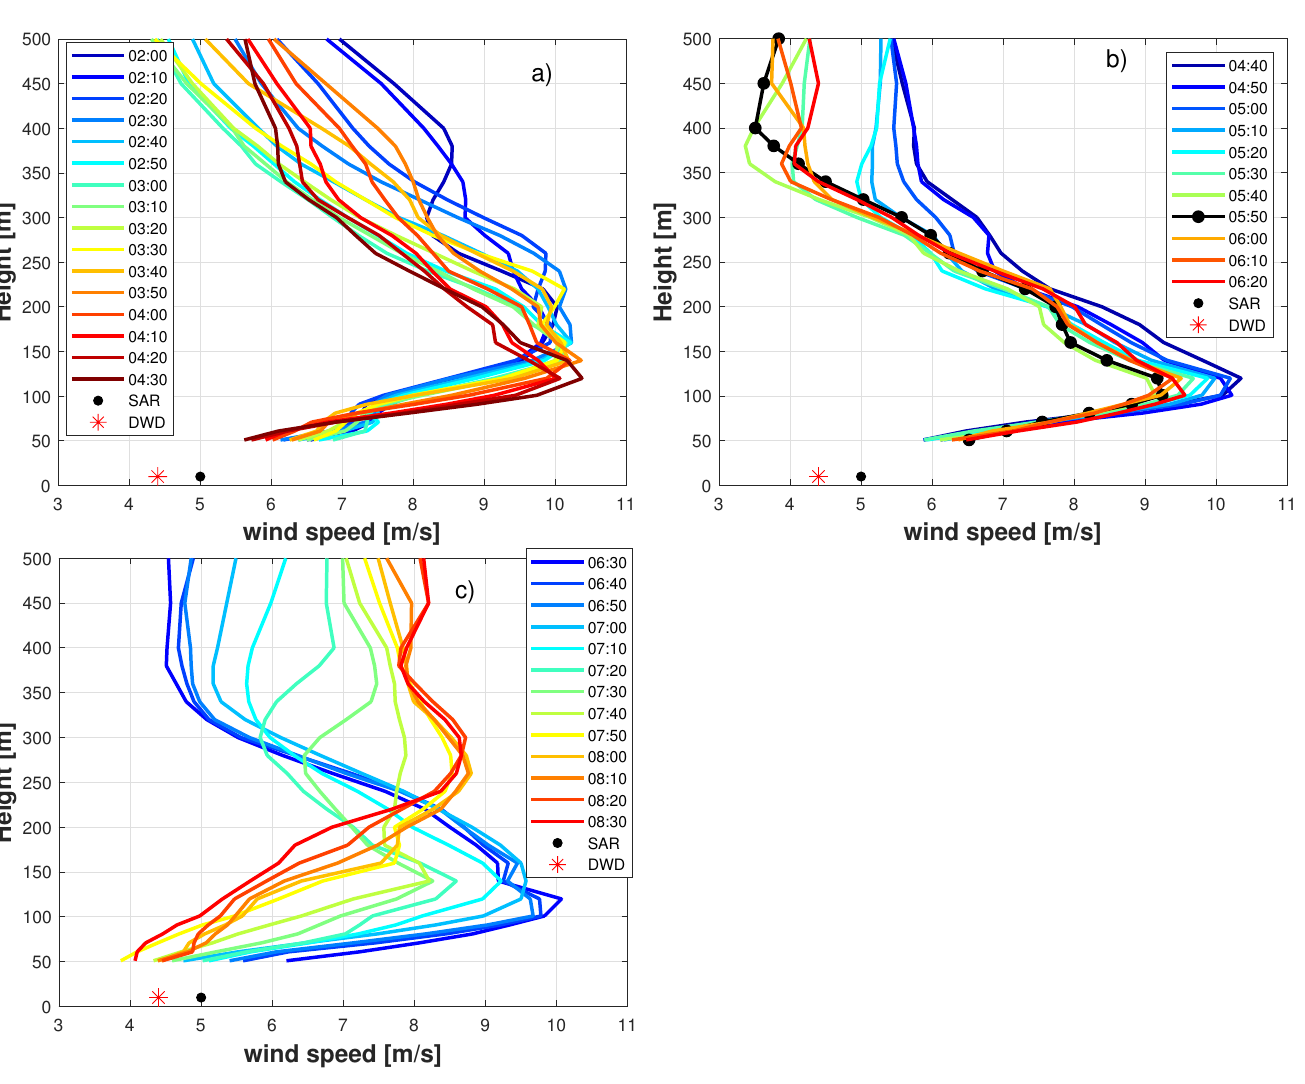
Figure 8. ( a – c ): Vertical profiles of wind speed from wind LIDAR on 25 August 2019 before the time ( a ), at the time ( b ) and after the time ( c ) of satellite measurement. Black dots and red star symbols represent, respectively, the wind speed from SAR and DWD at the location of the